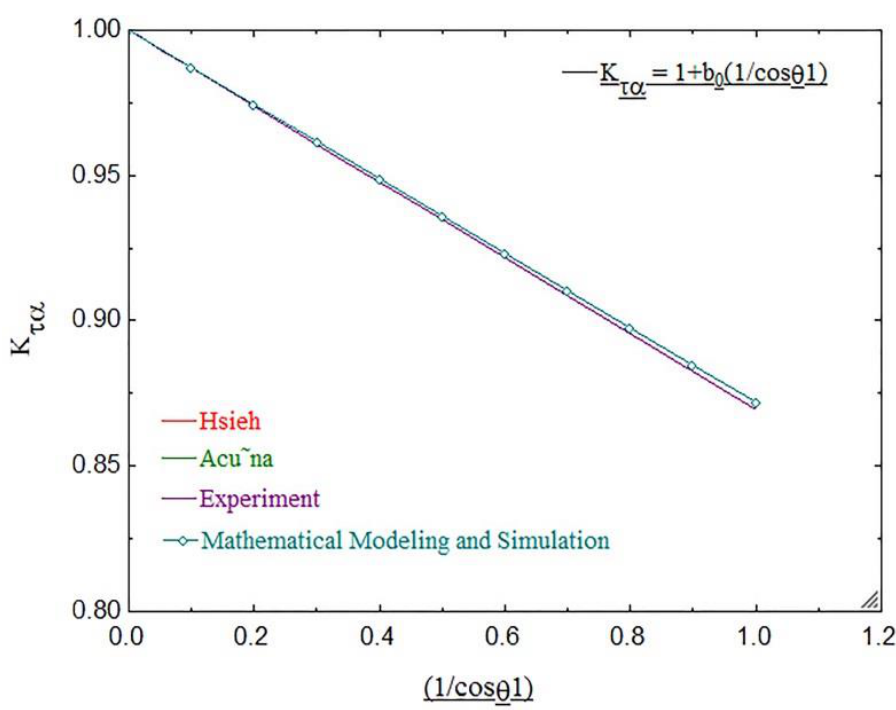
Figure 15. Absorption coefficient of CPC solar collector efficiency.